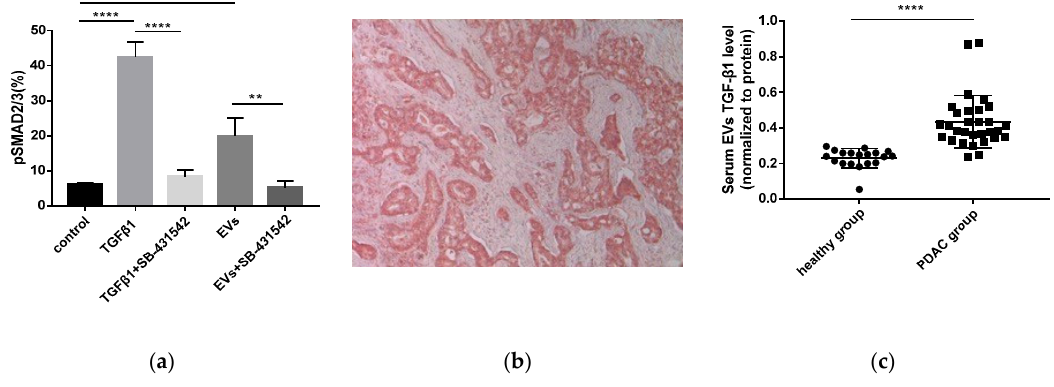
Figure 6. Pancreatic cancer-derived EVs inhibit NK cell function through the TGF β -Smad2/3 signaling pathway, and serum EVs’ TGF- β 1 is increased in pancreatic cancer patients. ( a ) After co-culture with TGF- β 1 or L3.6pl-derived EVs in the presence or absence of SB-431542, the phosphorylation level of SMAD2/3 in NK cells was measured by flow cytometry. Data are the means ± SD of four